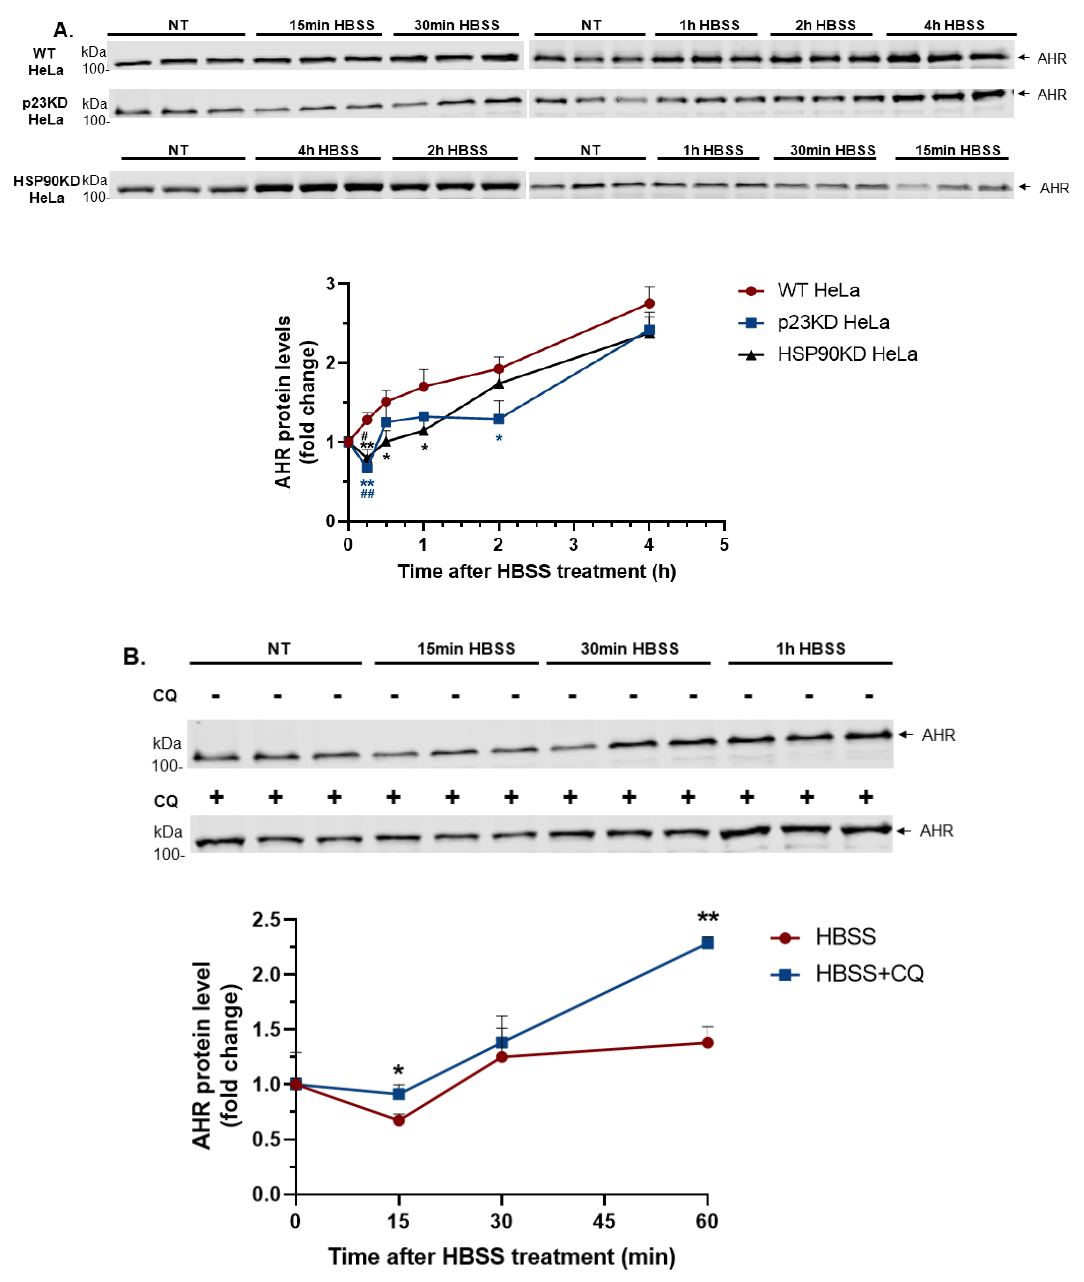
Figure 2. Cont Figure 2. Short-term nutrient deprivation triggers the degradation of AHR in HeLa cells when either p23 or HSP90 is down-regulated. ( A ) Zero to four hours’ treatment of HBSS (nutrient deprivation) in wild type (WT), p23 stable knockdown (p23KD), and HSP90 stable knockdown (HSP90KD) HeLa cells. Fifteen minutes of HBSS treatment decreased AHR protein levels in p23KD and HSP90 HeLa cells but not in WT HeLa cells. Longer nutrient deprivation of up to 4 h increased AHR protein levels in all three cell lines. The graph represents replicate data of means ± SD (upper error bars shown), n = 3 for all, except n = 4 for HSP90KD data from 0 to 1 h. Zero timepoints in each cell line were arbitrarily set as one for comparison. Data were analyzed by unpaired two-tailed t -test for comparisons between zero and 15 min timepoints in each individual cell line (significant data points marked with # symbol). Data were analyzed by two-way ANOVA (mixed-model) analysis corrected with the Dunnett test for multiple comparisons to determine the statistical significance between WT and p23KD or WT and HSP90 KD at each time point (significant data points marked with * symbol). WT HeLa data were set as a control group at each timepoint for comparison. The images above represent the replicate data. Note that the timepoints are intentionally presented not in chronological order to preserve the